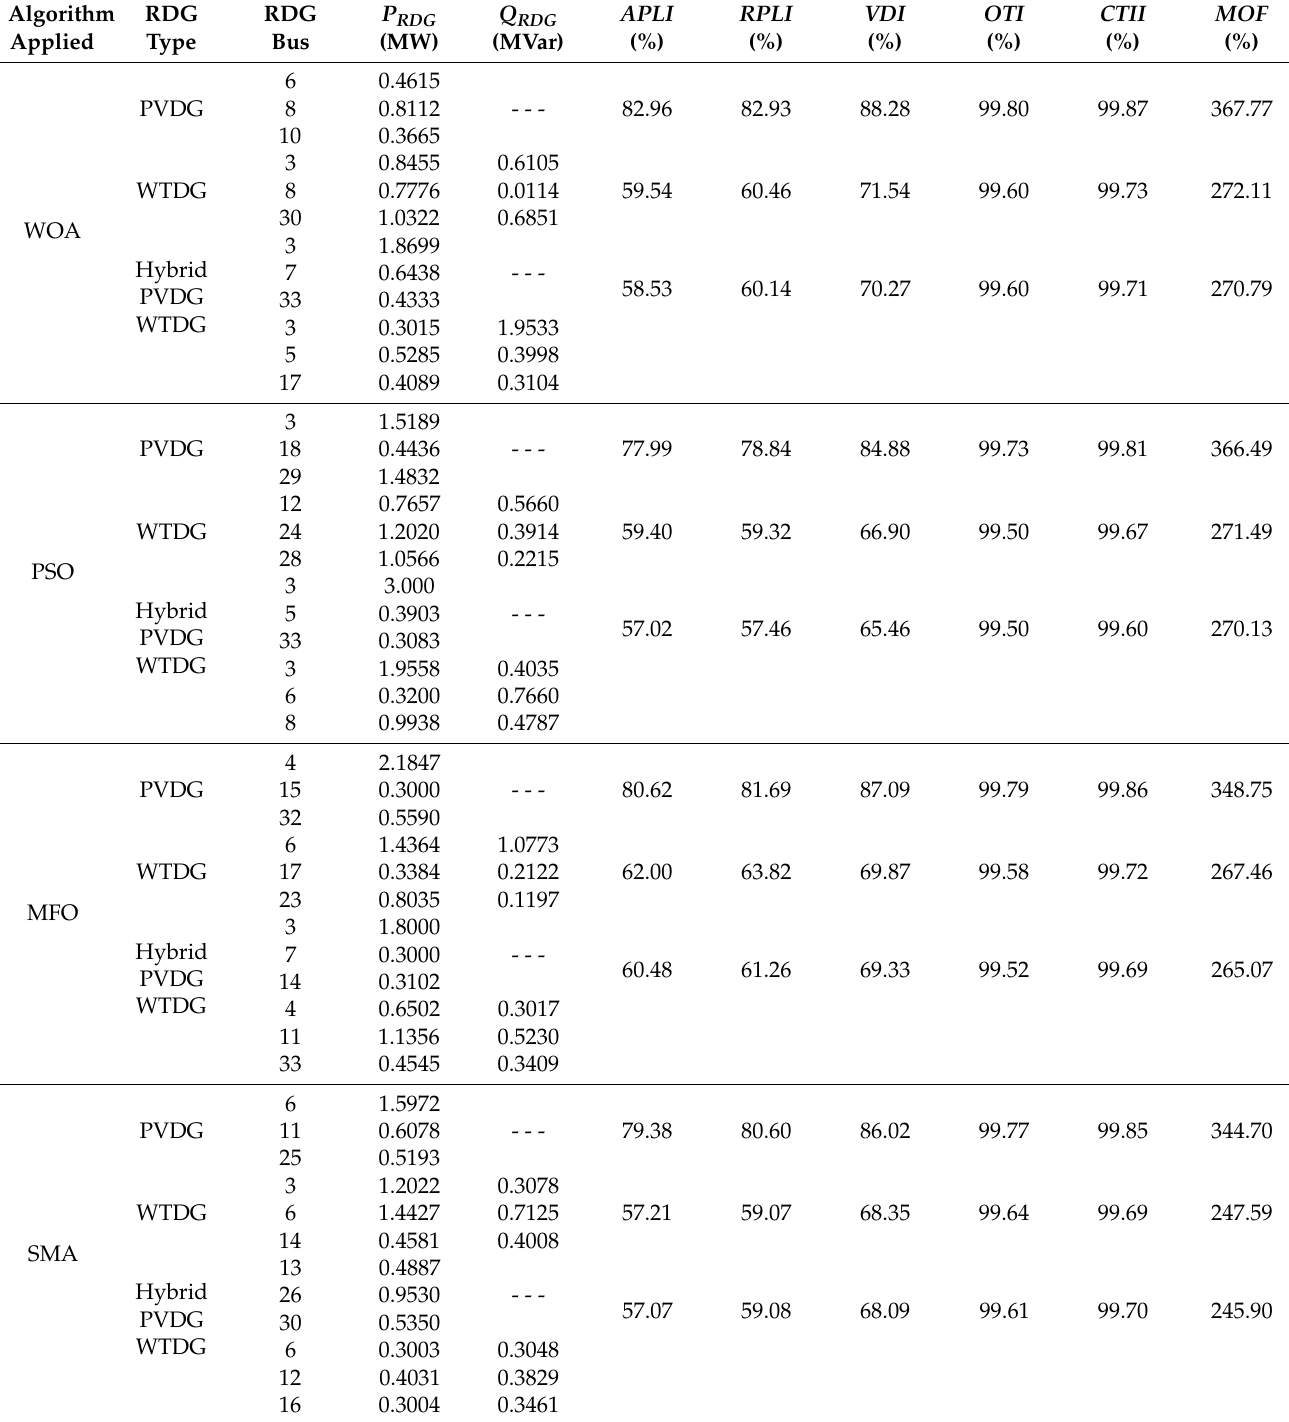
Table 2. The results after optimization for IEEE